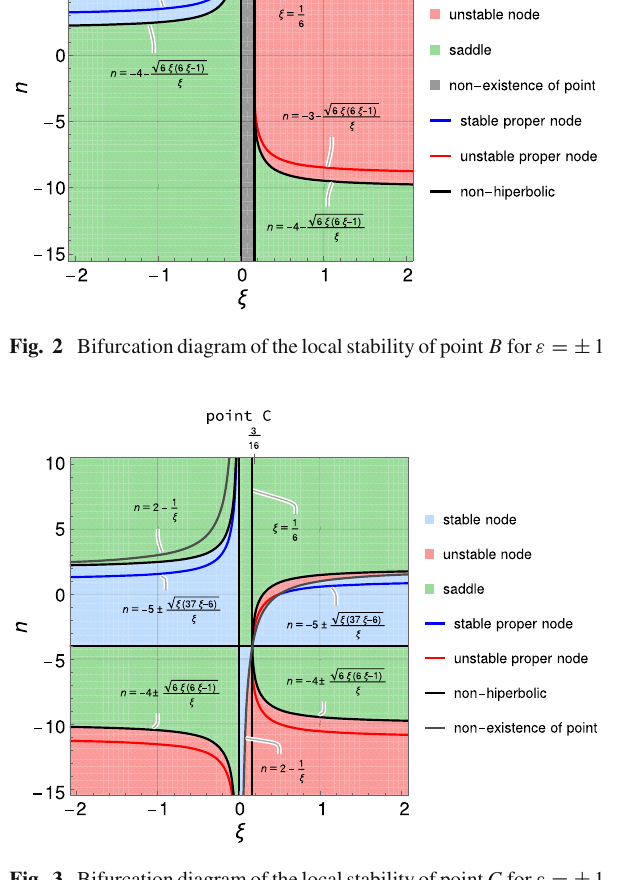
Fig. 3 Bifurcation diagram of the local stabilityof point C for ε = ± 1